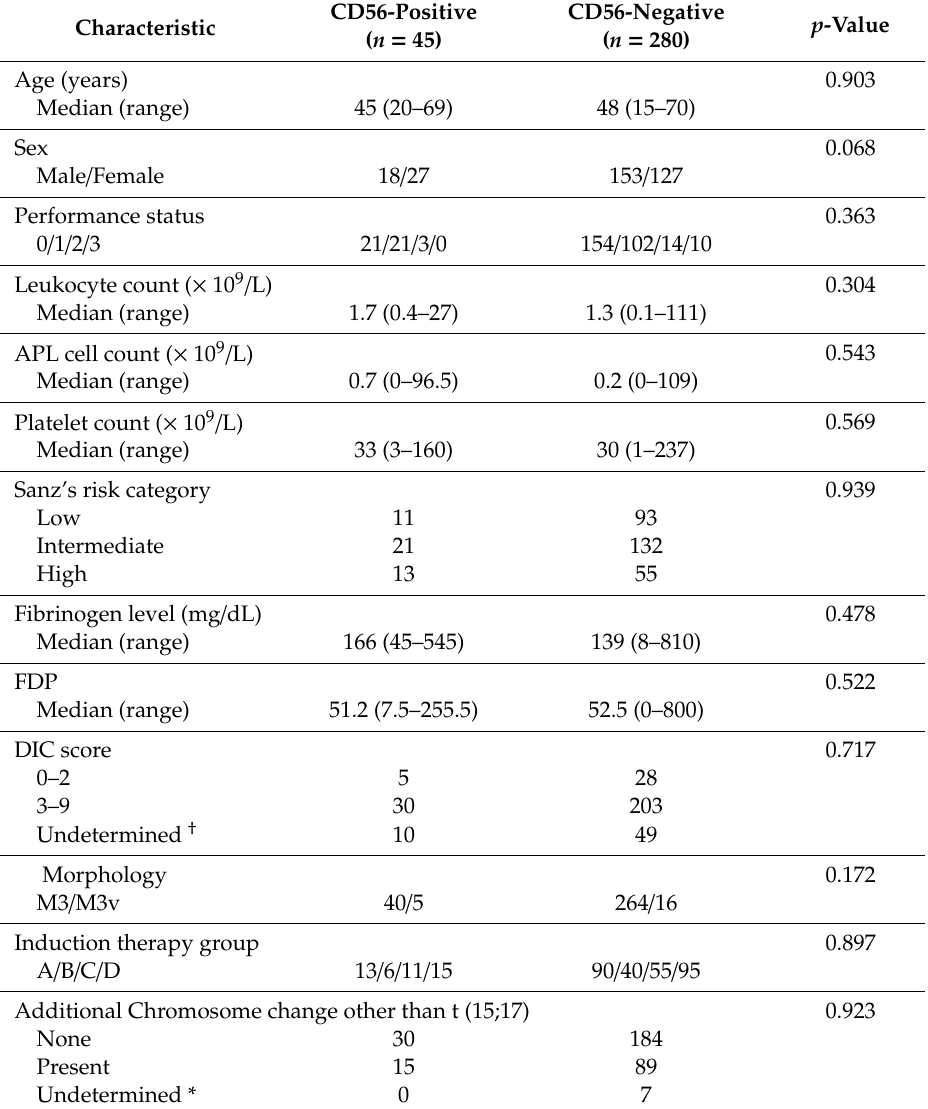
Table 5. Clinical feature of CD56 + and CD56 −